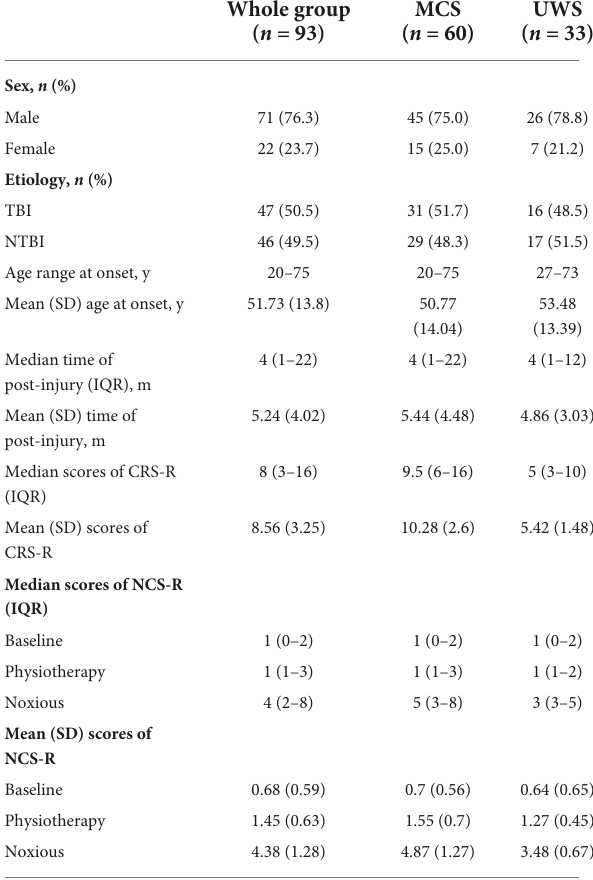
TABLE 1 Demographic characteristics and clinical data of disorders of consciousness (DOC) patients ( n =